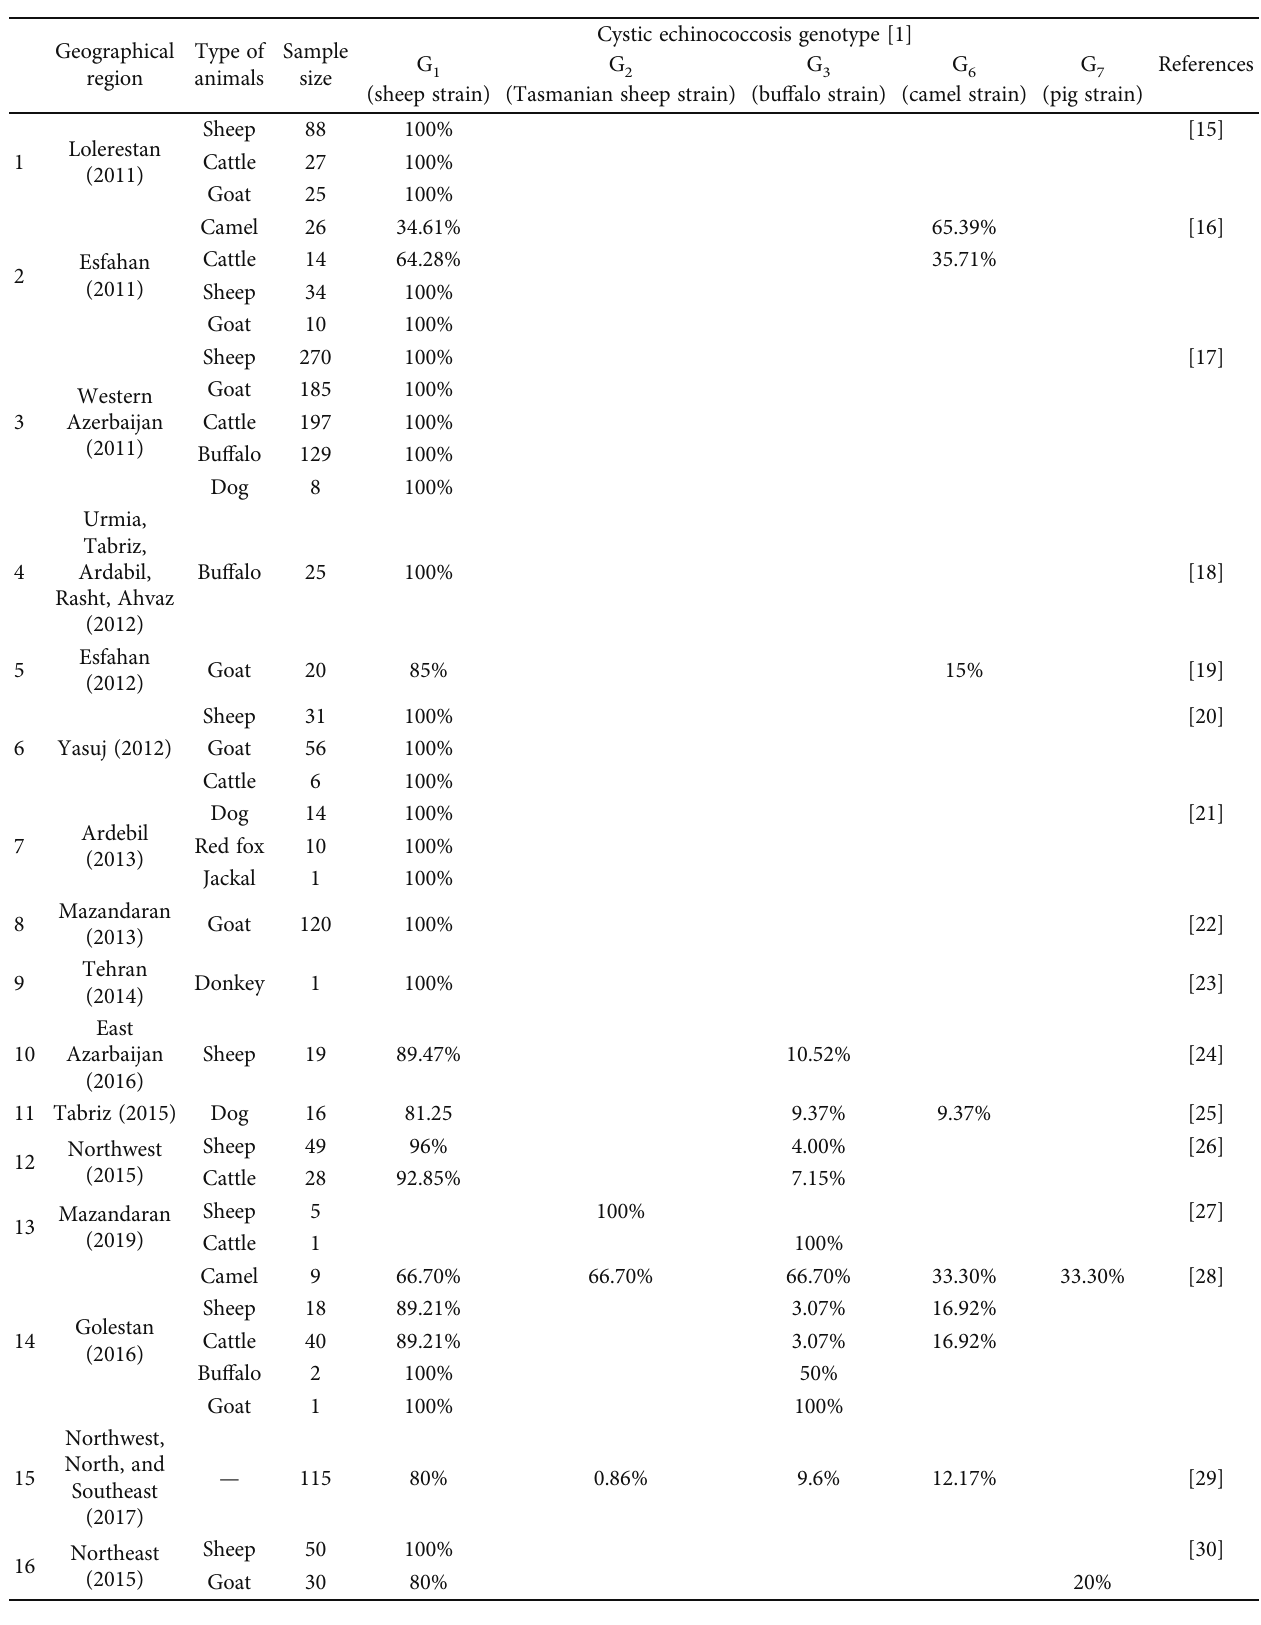
Table 1: Baseline characteristics of the 28 studies included in the meta-analysis of cystic echinococcosis relative frequency percentage in